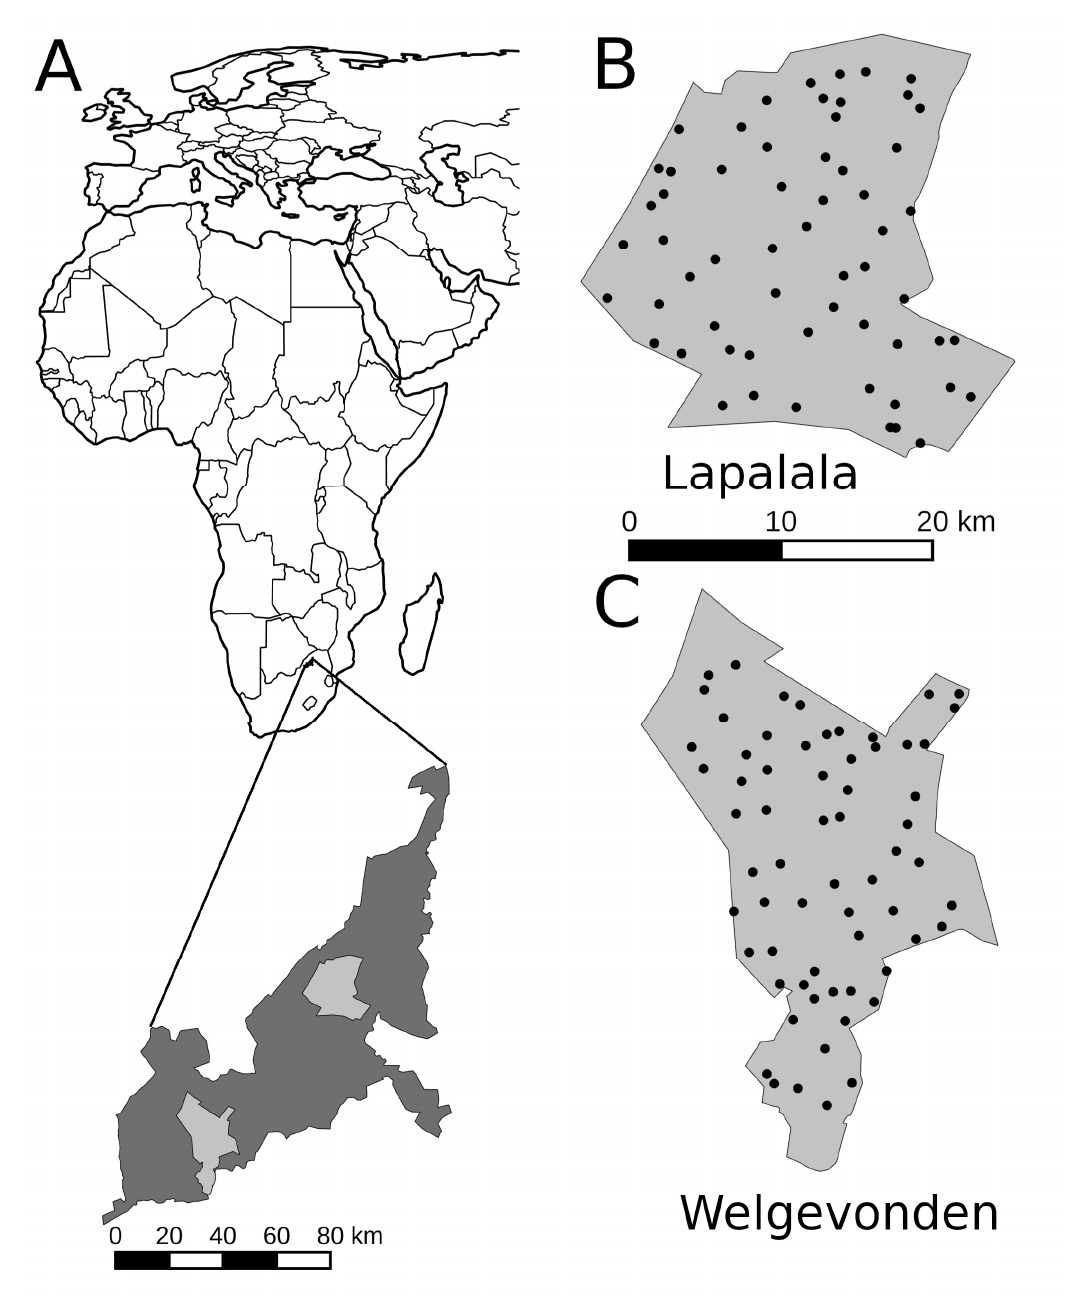
Figure 1. Locations of the two study areas in the Waterberg Biosphere, northern South Africa ( A ), as well as outlines of Lapalala Wilderness ( B ) and Welgevonden Game Reserve ( C ), including locations of the camera stations used for assessing relative abundance and habitat use of brown hyaenas and